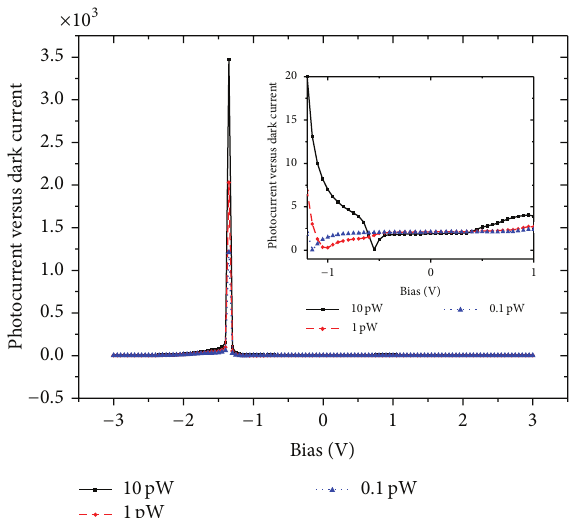
Figure 3: Ratio of the photocurrent versus dark current at illumina- tion 55 pw and bias changed from − 3V to 3V. The inset shows the enlargement of section bias range from − 1.2V to 1V.